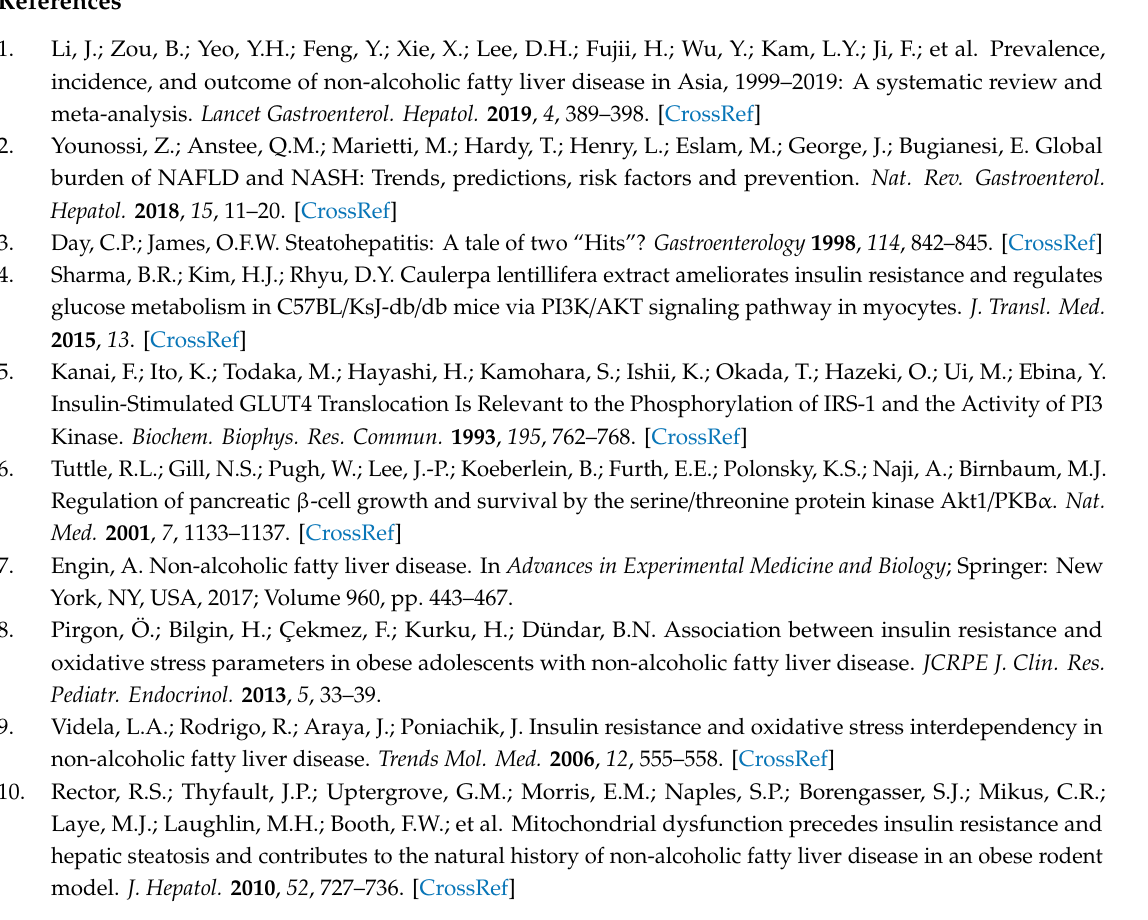
Table S1: The composition of experimental diets. Table S2: The sequences of primers used in RT-qPCR